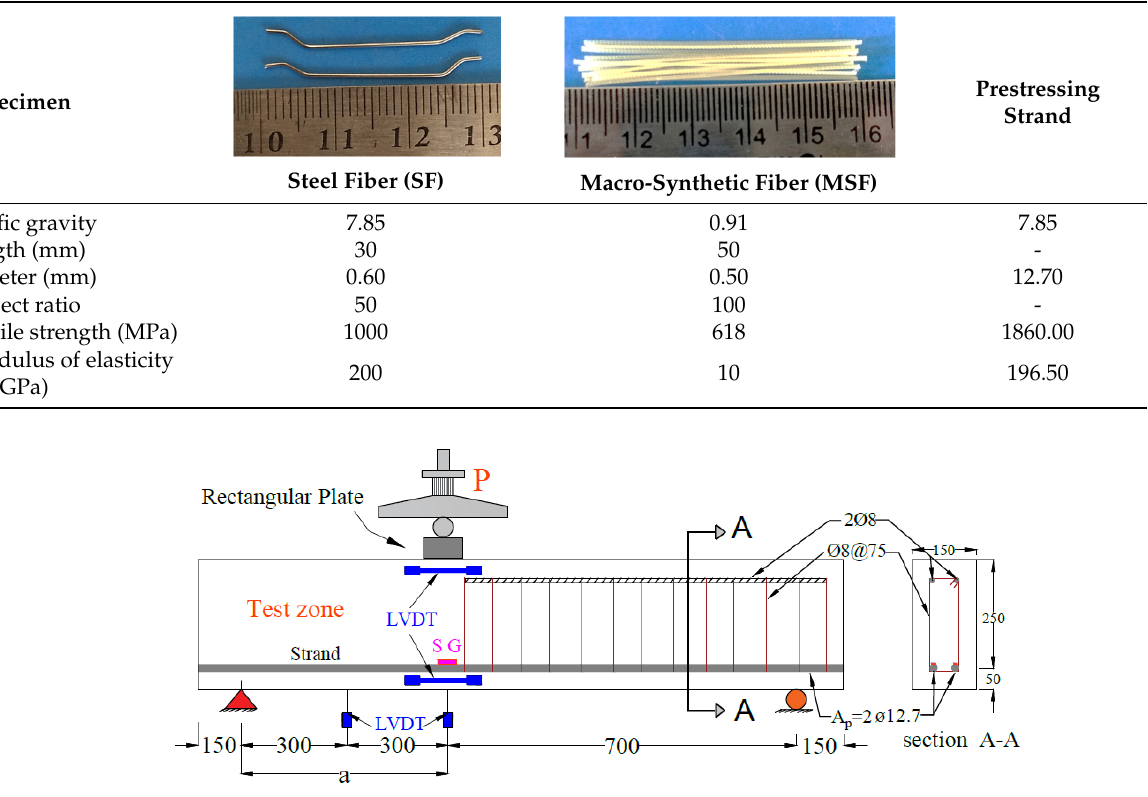
Table 1. Properties of fibers and prestressing strand.